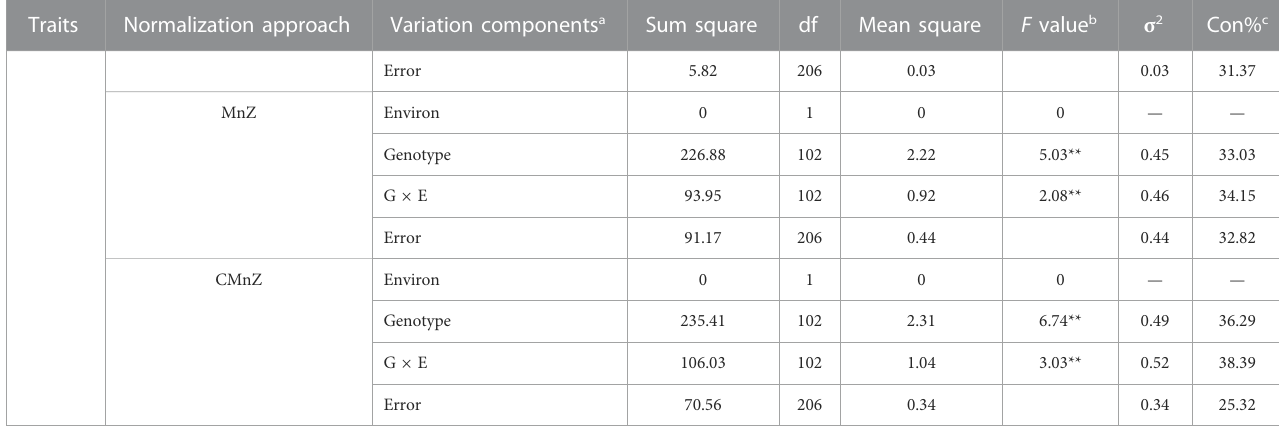
TABLE 1 ( Continued ) The phenotypic components analysis using two-way ANOVA for grain-Cd, grain-Mn, and grain-Zn performance in Pop6 grown in two Cd- contaminated paddy fi